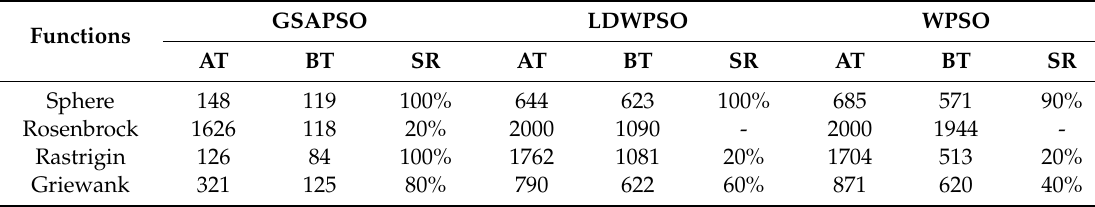
Table 3. Convergence speed of GSAPSO, LDWPSO and WPSO